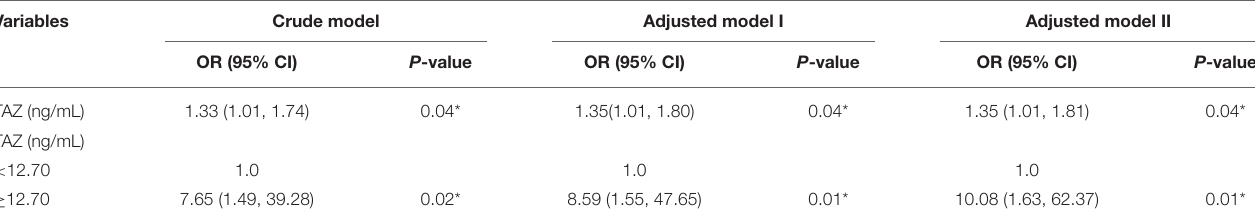
TABLE 3 | Relationship between the preoperative plasma level of TAZ and Postoperative in-hospital death in different adjusted models. Variables Crude model Adjusted model I Adjusted model II OR (95% CI) P -value OR (95% CI) P -value OR (95% CI) P -value TAZ (ng/mL) 1.33 (1.01, 1.74) 0.04* 1.35(1.01, 1.80) 1.35 (1.01, 1.81)